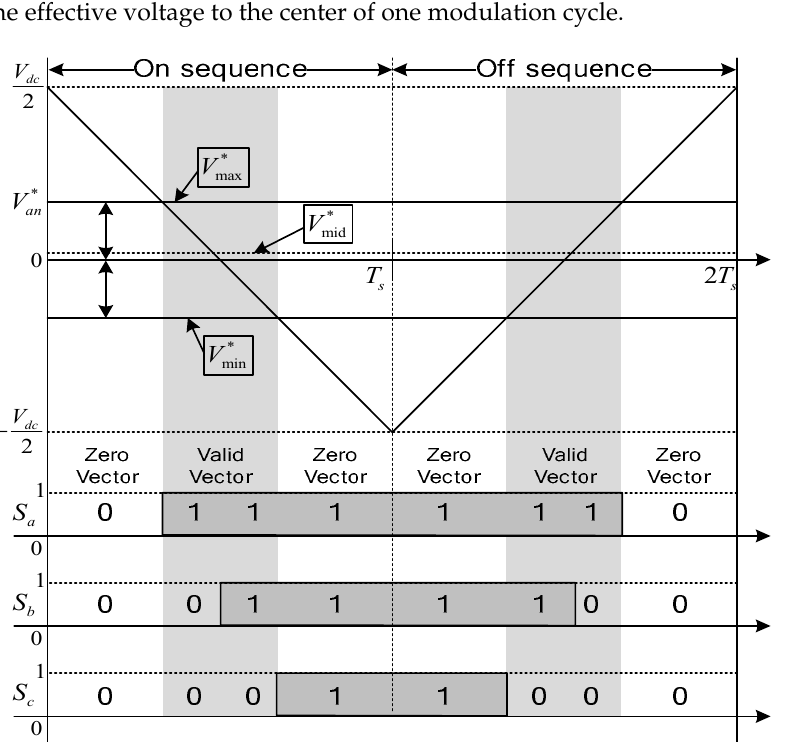
Figure 6. Technique for symmetric SVPWM.